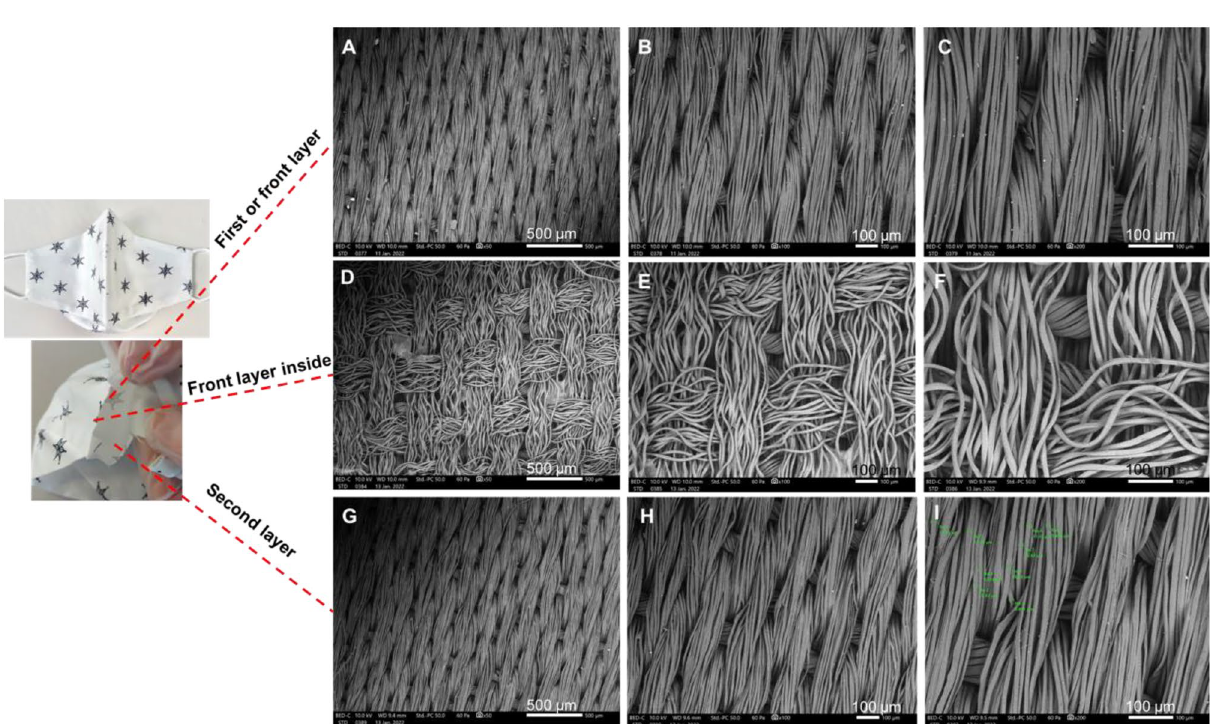
Figure 6. SEM for each of the two layers of a silk face mask with nose wire - pure mulberry silk breathable. ( A – C ) front layer. ( D – F ) the back of front layer. ( G – I ) second